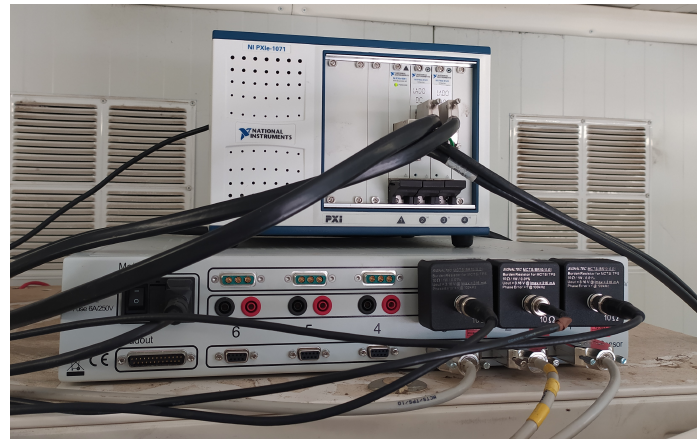
Figure 2. Part of the measurement system: NI Chassis and MCTS II.